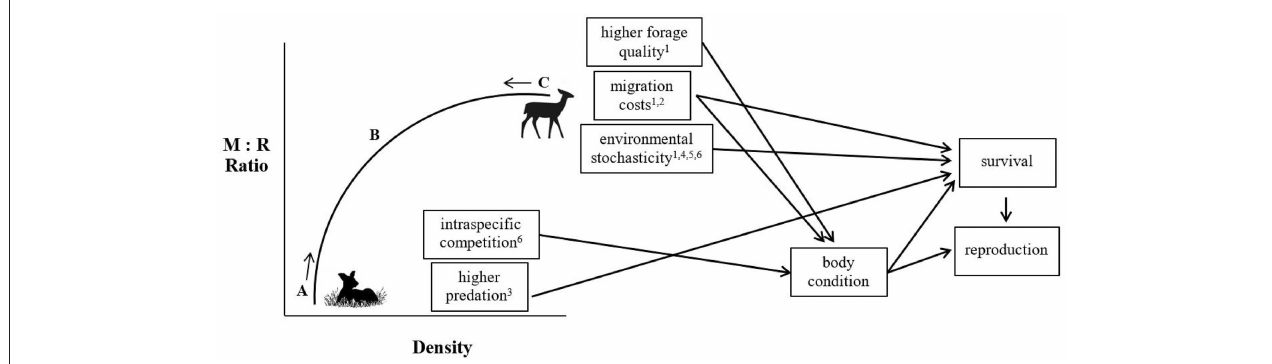
FIGURE 2 | Conceptual framework depicting how the density-dependent and density-independent factors may interact on the vital rates of migrants and residents to maintain partial migration within a population. Migrants (M) may do better in one vital rate at high density, but residents (R) will do better in another vital rate at low density. This “demographic balancing” may not happen every year, but will prevent fixation of the proportion of migrants at either 0 or 1, and provide the mechanism for the long-term average ratio of M:R in a population. (A) With each additional R individual, individual fitness for each R individual declines, and density dependence in predation or competition, or alternatively, stochastic climate events, shift the M:R ratio back toward (B), the point at which partial migration is maintained. (C) With each additional M individual, fitness for each M individual declines. However, very little empirical evidence to support demographic balancing is found in the partially migratory ungulate literature because most studies are not long-term, or examine only 1 or 2 vital rates. For examples, see (1) Nicholson et al. (1997) (2) Hebblewhite and Merrill (2011) (3) White et al. (2014) (4) Middleton et al. (2013a) (5) Fieberg et al. (2008) (6) Plumb et al.